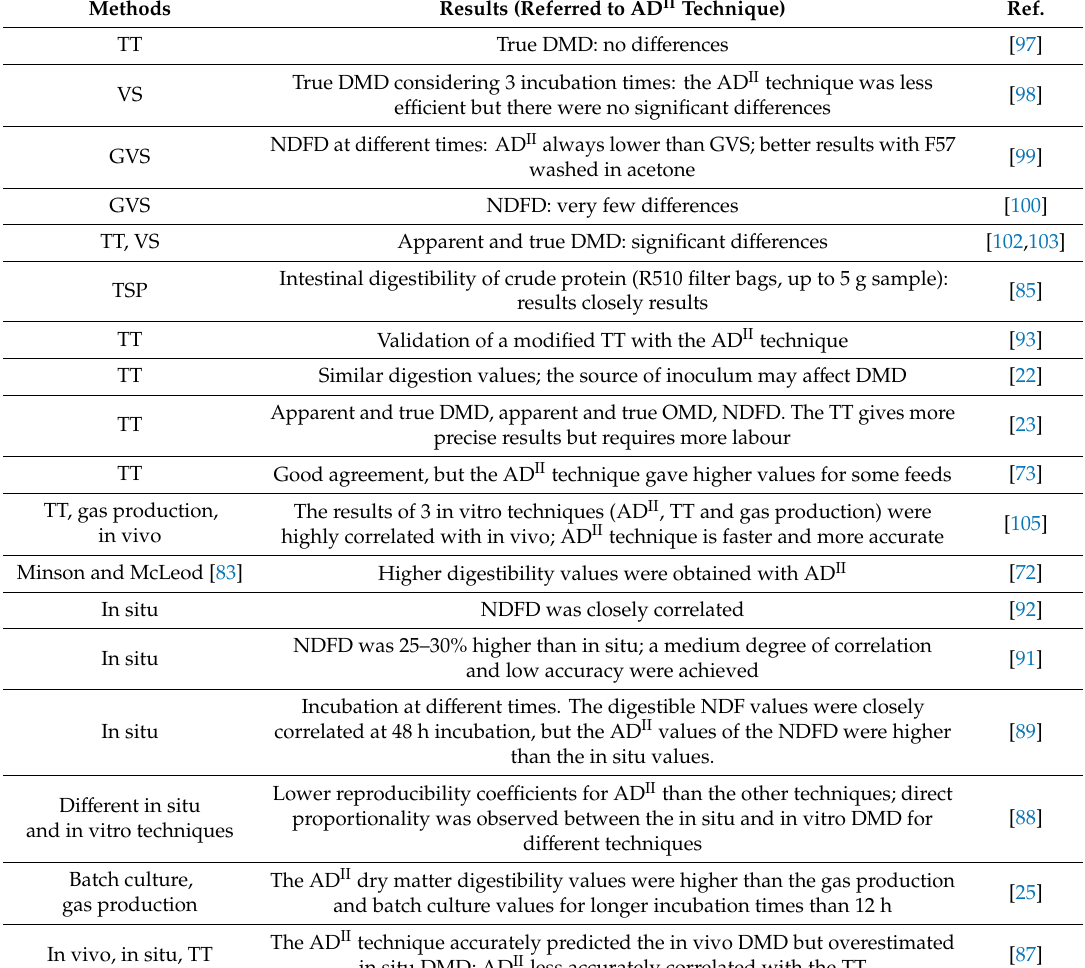
Table 5. Comparison of the Ankom Daisy II incubator (AD II ) with other digestibility methods. Methods Results (Referred to AD II